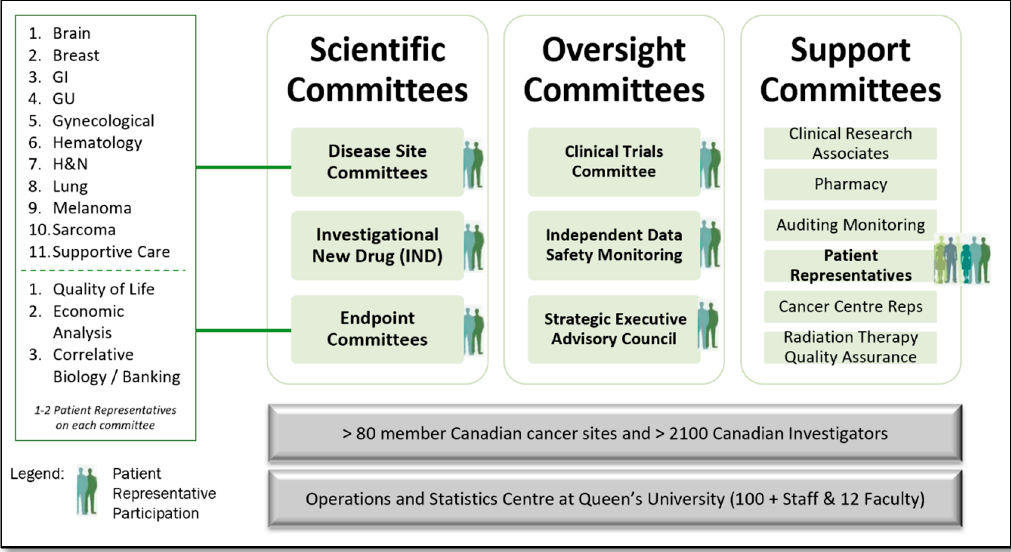
Figure 3 . Patient Engagement in the Canadian Cancer Trials Group Committee Structure. Figure 3. Patient Engagement in the Canadian Cancer Trials Group Committee